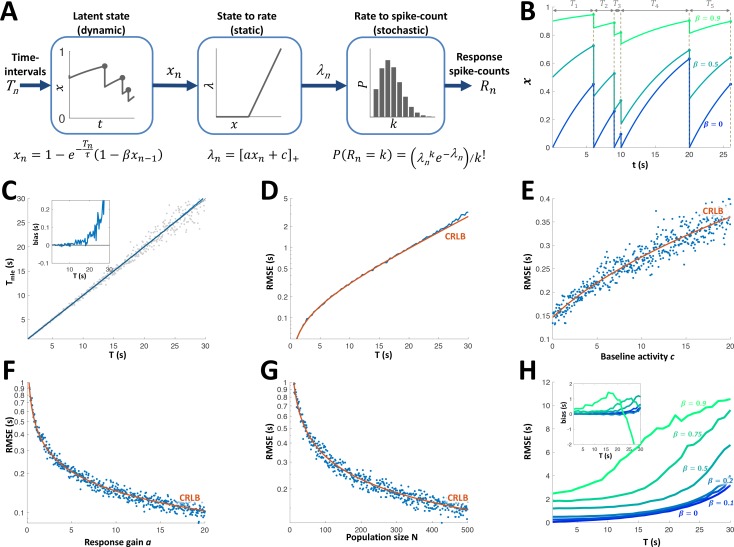
Adaptation model and Maximum Likelihood Estimation of time inteval (A) Block diagram of adaptation model, which includes three stages: a dynamic latent state variable x with memory parameter β and exponential recovery with time-constant τ; a static non-negative mapping from state x to firing parameter λ, with gain parameter a and baseline parameter c; and a stochastic spike-count generator (Poisson random variable with parameter λ).(B) Examples of state variable dynamics due to a random encounter sequence, for different values of β. Note that when β=0, each encounter entails complete reset of x to 0, thus generating the history independence property. (C) MLE of time interval with a homogeneous population. Grey circles: individual estimations; blue curve: mean; black line: identity diagonal. Inset: estimation bias. (D) Blue: root-mean-squared estimation error (RMSE, log scale) vs. time interval. Red: Cramér-Rao Lower Bound (CRLB). (E) RMSE vs baseline activity c. (F) RMSE (log scale) vs. response gain a. (G) RMSE(log scale) vs. population size N. (H) RMSE for different values of β. Inset: estimation bias. In all simulations β=0,τ=10s,a=10,c=0,N=500,T=5 unless stated otherwise.